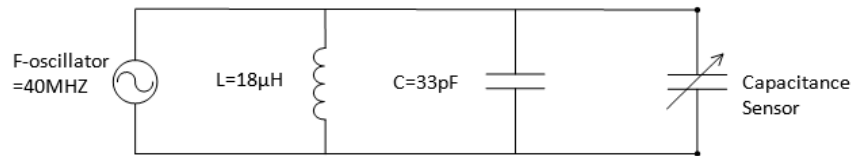
Figure 6. LC oscillator circuit connected parallel to the capacitance sensor.